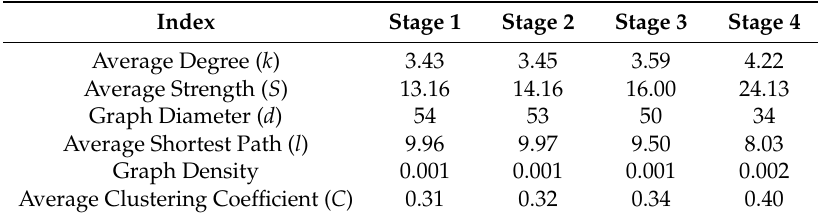
Table 5. The whole railway network index in four